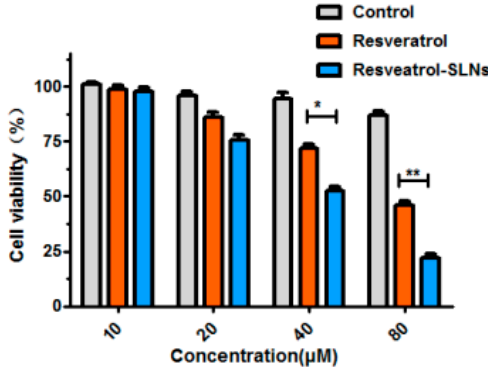
Figure 4. Cell viability of MDA-MB-231 cells measured by using the SRB assay after exposure to free Resveratrol and Resveratrol-SLNs ( n = 3). Bars represent mean ± S.D. and asterisks denote a significant difference (* P < 0.05; ** P < 0.01 and *** P < 0.001). Data are representative of at least three independent experiments